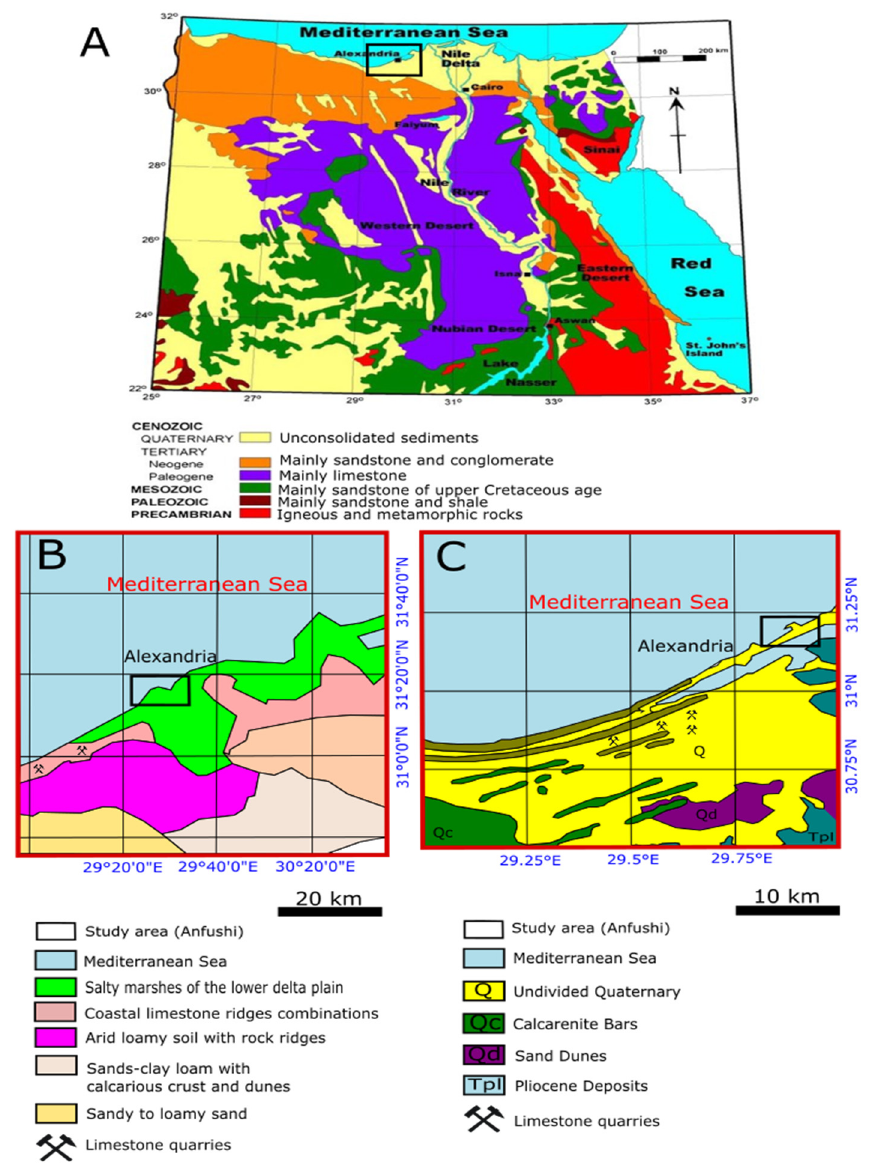
Figure 4. ( A ) Geological map of Egypt (black rectangle refers to Alexandria) from [39]. Detailed maps for soil units ( B ) and geological map ( C ) of Alexandria, edited after [43]. Black rectangles refer to the study area.